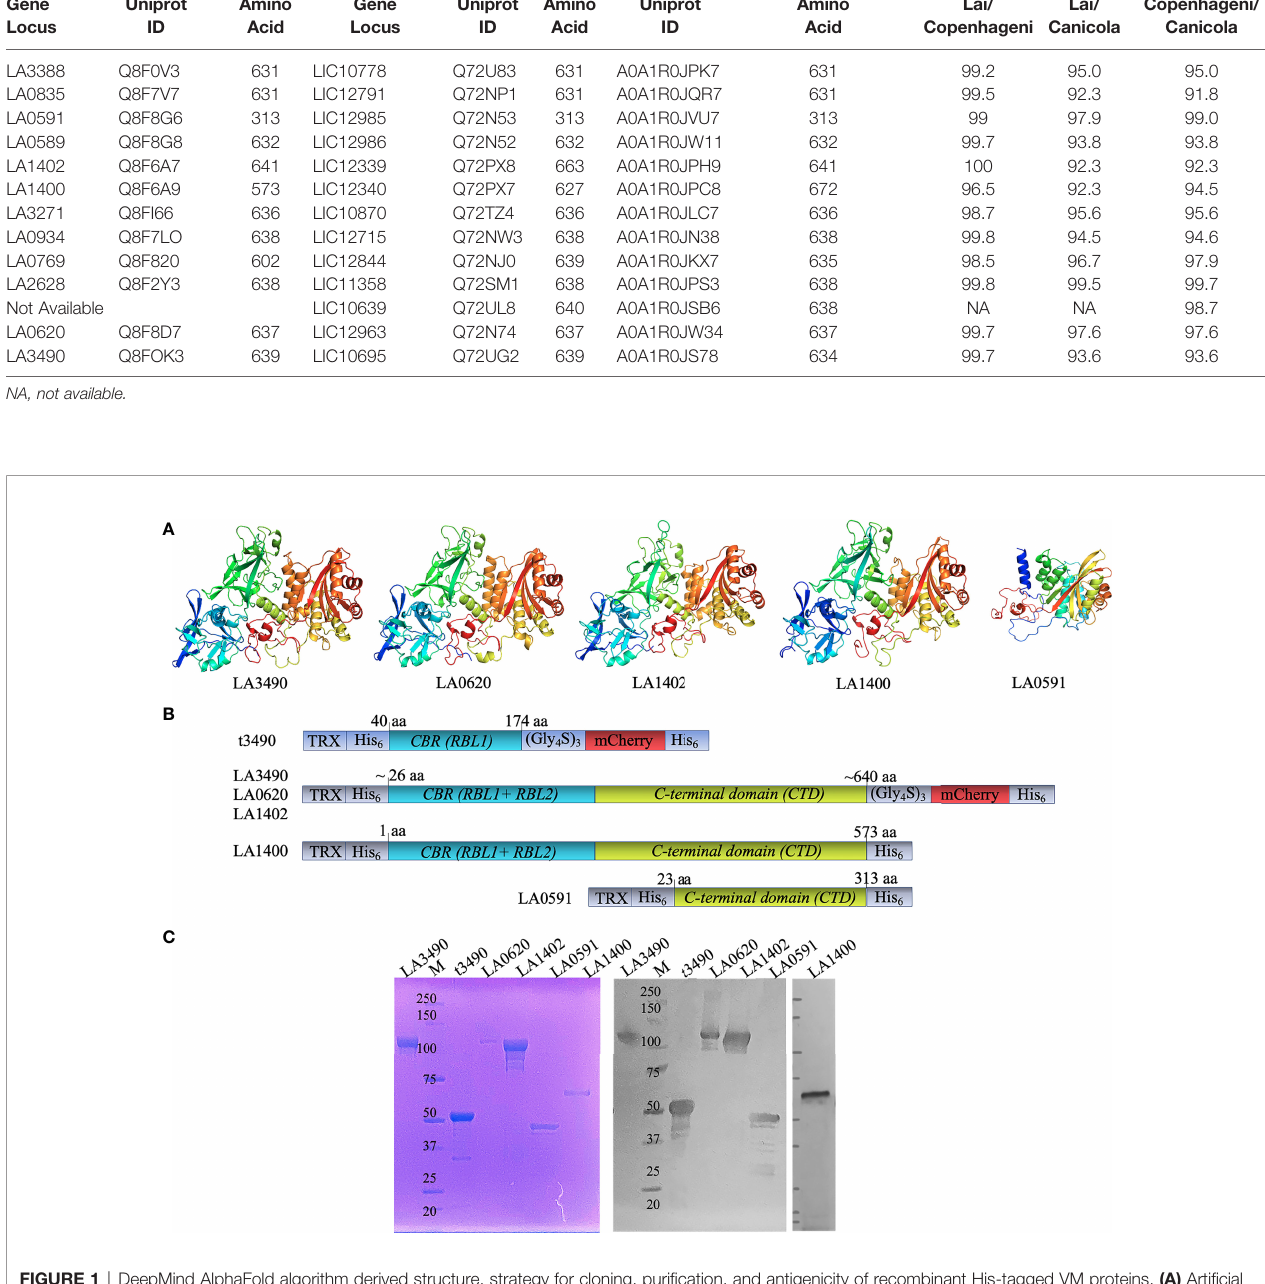
FIGURE 1 | DeepMind AlphaFold algorithm derived structure, strategy for cloning, puri fi cation, and antigenicity of recombinant His-tagged VM proteins. (A) Arti fi cial intelligence-based high-resolution structural modeling of (LA3490, LA0620, LA1402, LA1400 and LA0591) using AlphaFold algorithm [Callaway, E. (2020)]. (B) Schematic diagram depicting the organization of the recombinant mCherry (mC) fusion VM proteins used in the current study; t3490, amino acid positions 40 aa -147 aa (minus signal sequence); LA3490 (19 aa – 639 aa), LA0620 (32 aa – 637 aa), LA1402 (28 aa - 641 aa), LA1400 (1 aa - 573 aa), and LA0591 (23 aa – 313 aa). The clones were designed without signal sequences. LA1400 naturally lack signal sequence. Recombinant fusions include a glycine-serine (Gly 4 S) 3 linker (for fi cation), and N-terminal thioredoxin. (C) AKTA puri fi ed soluble His-tagged VM proteins (LA3490, t3490, LA0620, LA1402, fl exibility), N-and C-terminal His 6 tag (puri LA0591, and LA1400) were analyzed by 4 ± 12% SDS-PAGE followed by Coomassie staining. A replicate gel was run for immunoblot analysis. The proteins were transferred to a nitrocellulose membrane and the blot was probed with mouse anti-His monoclonal-ALP conjugate (1:2,000 dilution; Santa Cruz Biotechnology, USA). M represents molecular weight